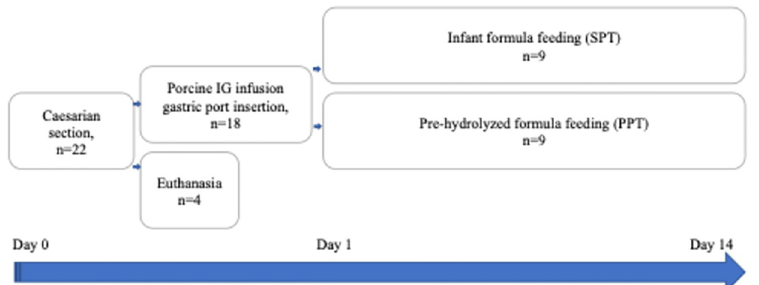
Fig 1. Schematic representation of the study design. IG—immunoglobulins, SPT—preterm piglets fed infant formula; PPT—preterm piglets fed pre-hydrolyzed infant formula.